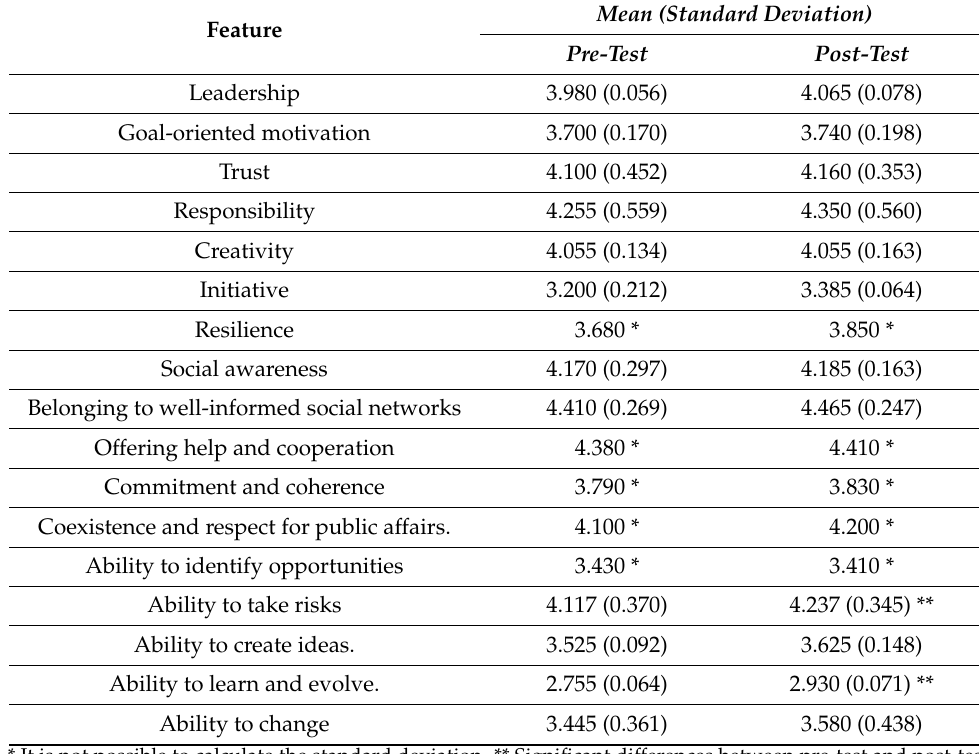
Table 3. Pre-test/post-test values by features.